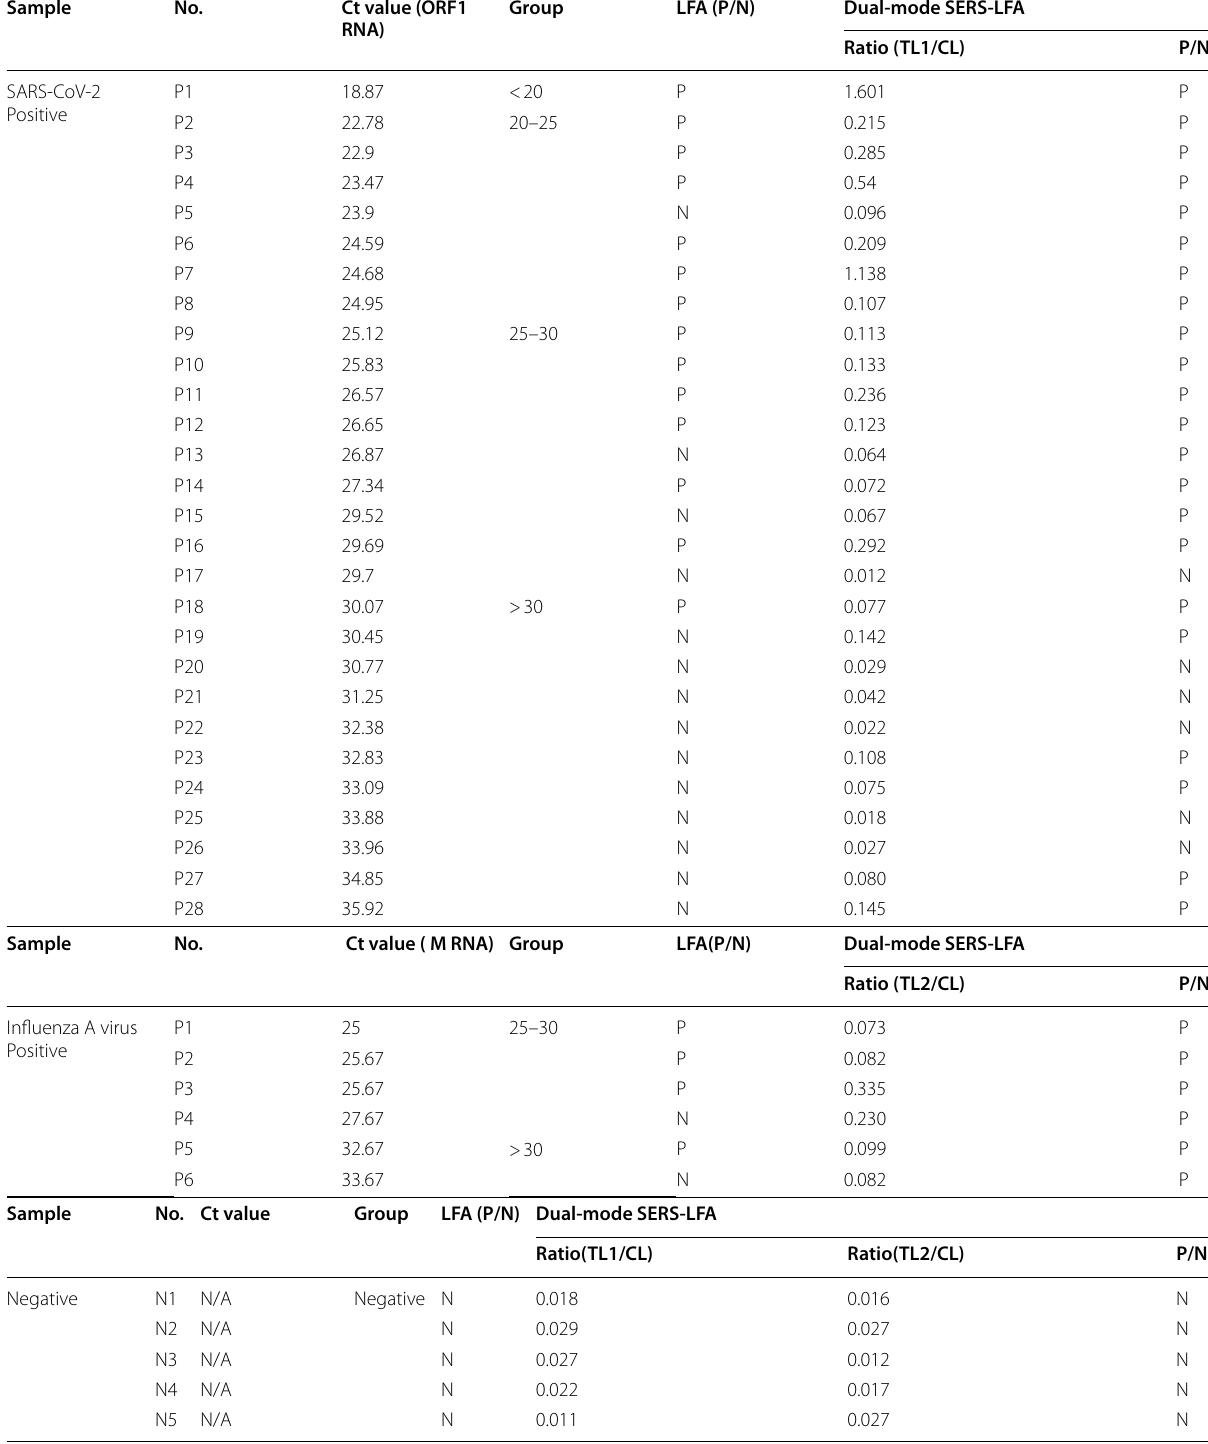
Table 1 Clinical assay results for SARS-CoV-2 and influenza A virus using RT-PCR, commercial LFA, and dual-mode SERS-LFA strips performed on 39 patient samples Sample